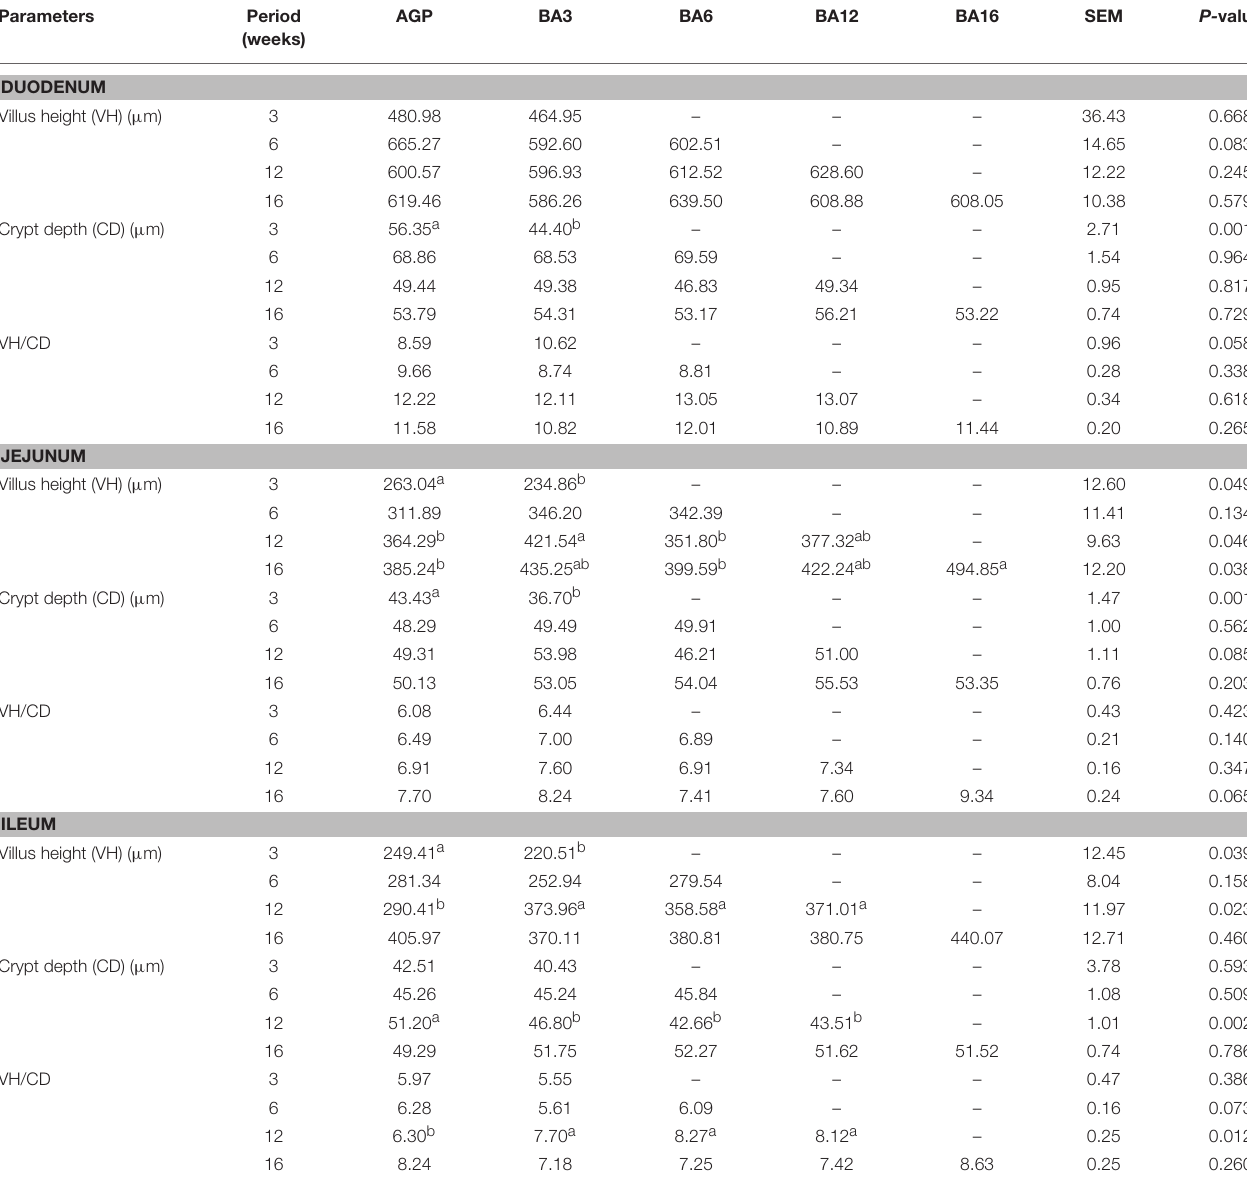
TABLE 5 | Villus height, crypt depth, and villus height/crypt depth ratio in the small intestine of pullets fed on different dietary treatments from 0 to 16 weeks.